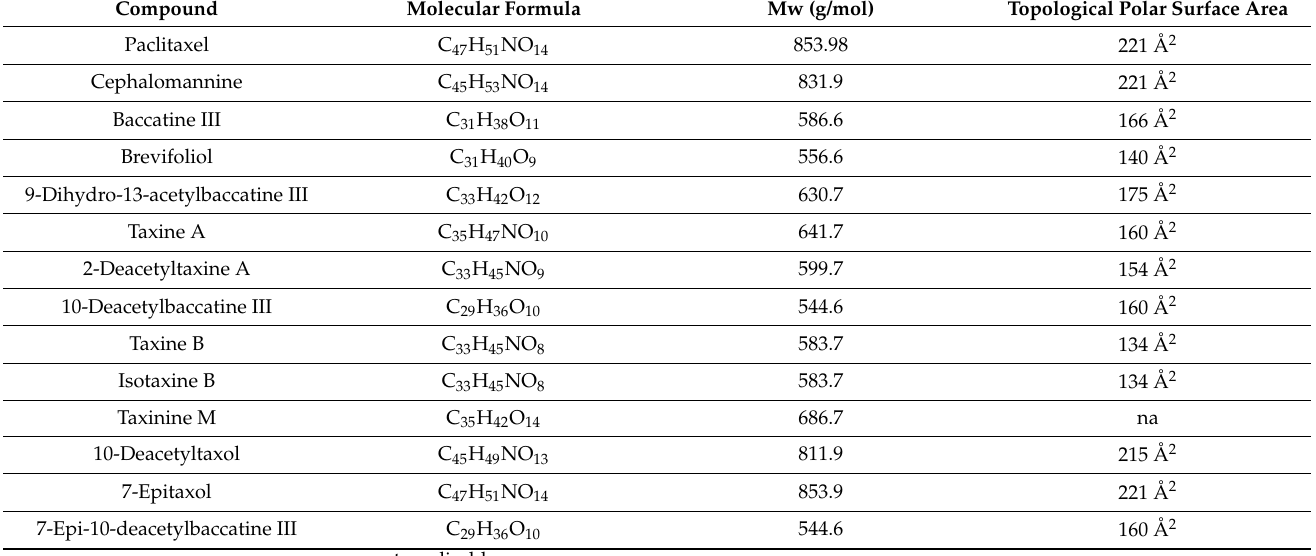
Table 2. Characteristics of selected taxanes, including molecular weight, general formula, polarity. Data were obtained from https://pubchem.ncbi.nlm.nih.gov/ (accessed on 5 November